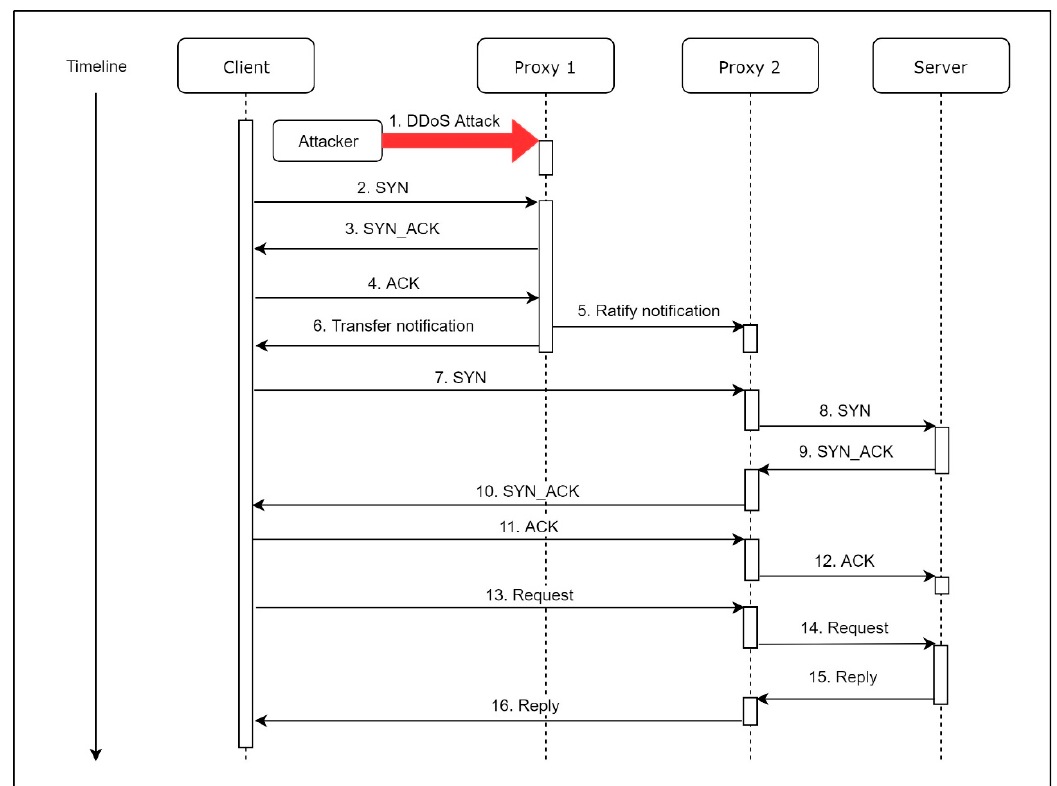
Figure 4. Execution flow of Migration Sensor (MS) under DDoS attacks.